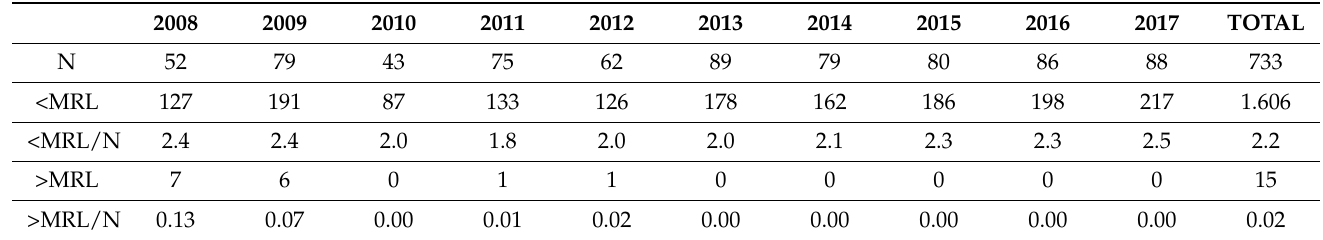
Table 6. No. of residues per sample 2008–2017; (N: no. of samples; <MRL: no. of residues < MRL; >MRL: no. of residues > MRL; <MRL/N: ratio of residues < MRL per sample; >MRL/N: ratio of residues > MRL per sample).